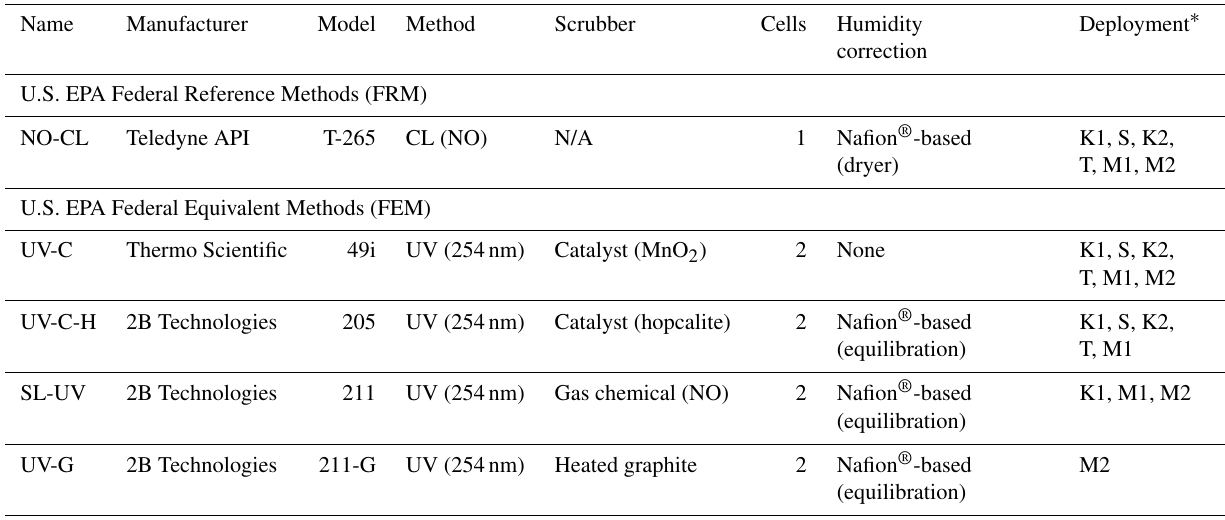
Table 1. Ozone measurement methods investigated. N/A – Not